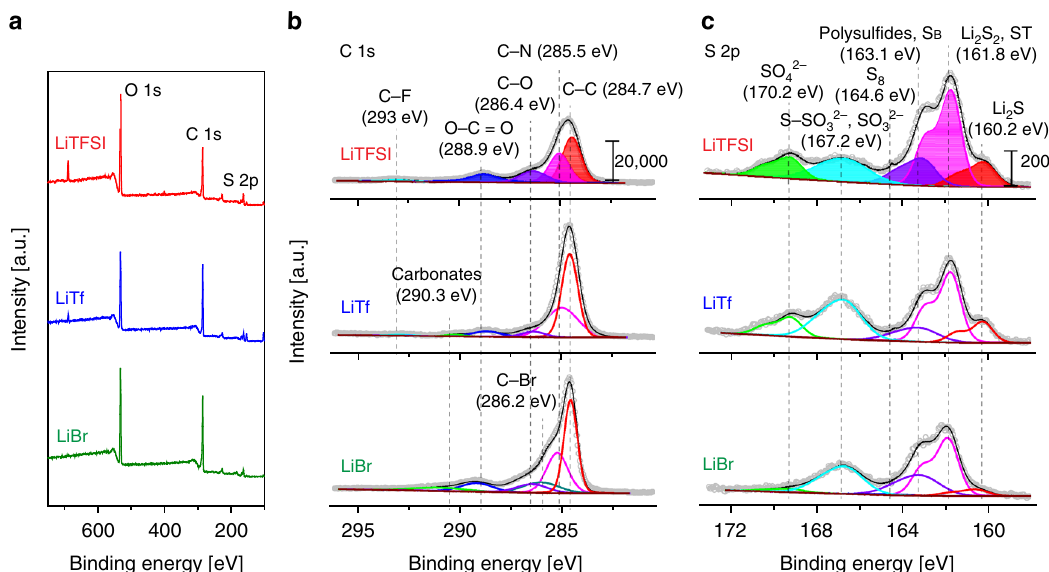
Fig. 3 Surface characterization of discharged carbon paper electrodes. a X-ray photoelectron spectroscopy (XPS) survey scans of the carbon paper (CP) electrodes after discharging 400mA h g − 1 with the catholytes using the three different salts, lithium bistri fl imide (LiTFSI), lithium tri fl ate (LiTf), and lithium brom0ide (LiBr). b Comparisons of C 1 s , and c S 2 p spectra of the discharged cathodes with the three electrolytes